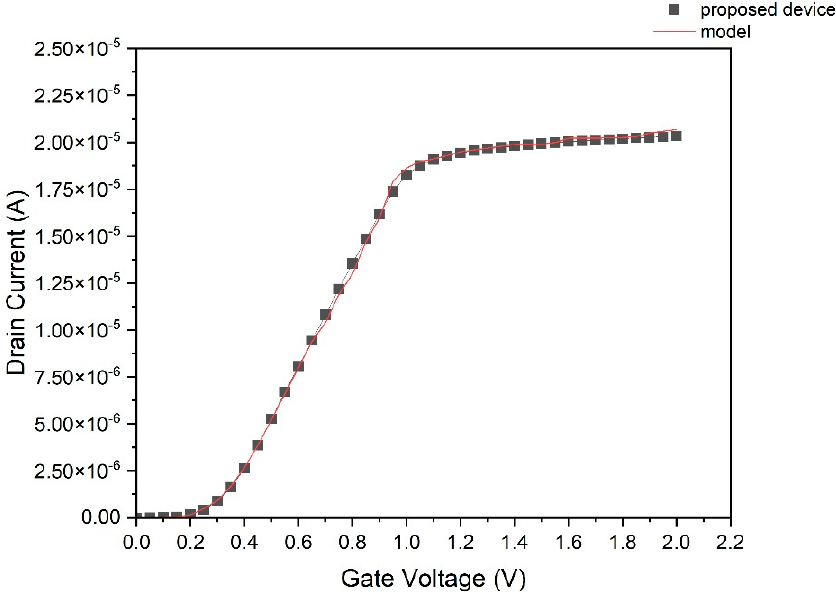
Figure 5. Transfer characteristic curves: TCAD simulation of the device used in this study and the traditional device model.